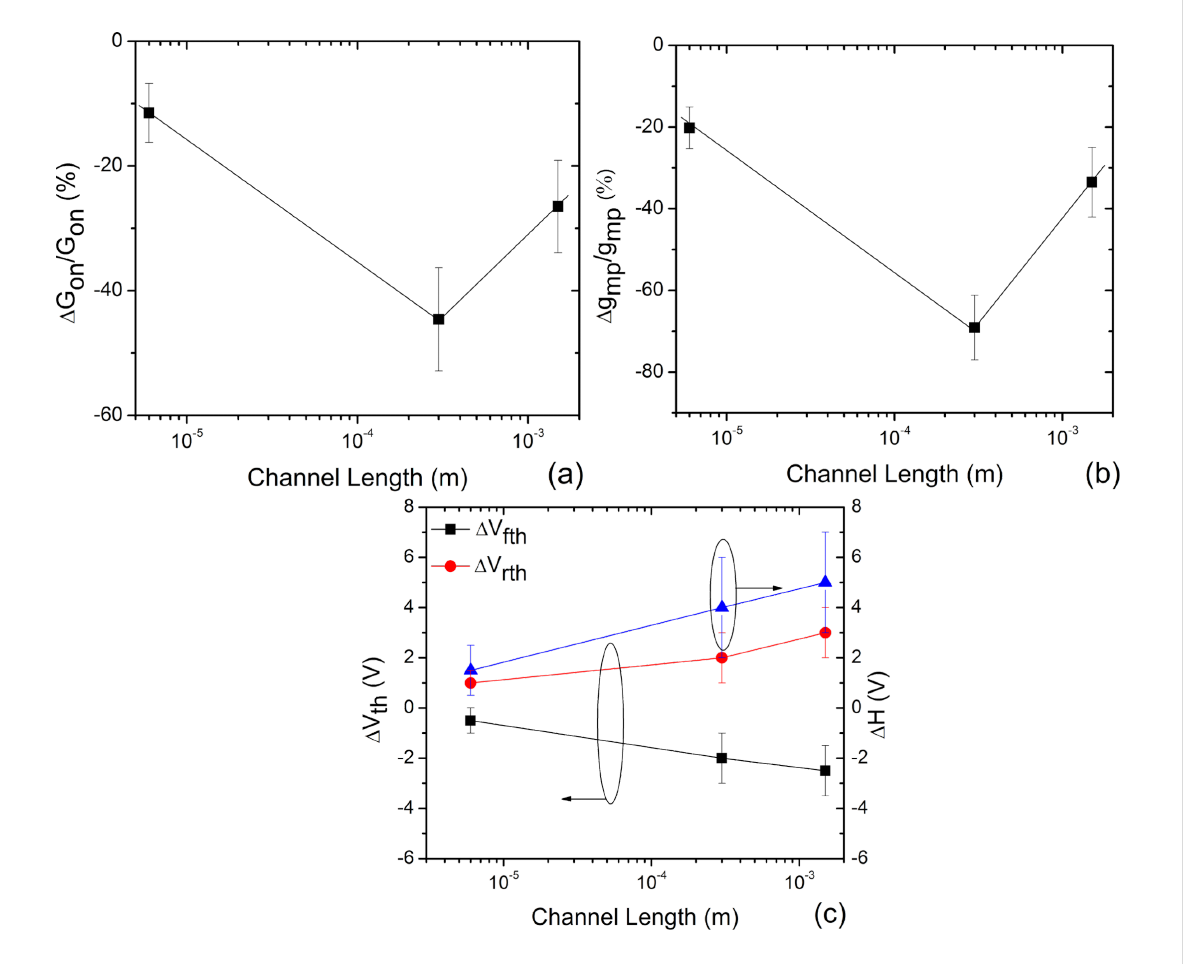
Figure 4: The relative (a) on state conductance ( Δ G on / G on ) and (b) peak transconductance ( Δ g mp / g mp ) after cDNA exposure, expressed in percent, for three different FET channel lengths ( L = 6 µm, 300 µm and 1500 µm) with both the channel and junction exposed. The negative sign on the y-axis indicates the decrease in magnitude of these two parameters after DNA hybridization. (c) The variation of the change in forward sweep threshold voltage ( Δ V fth ), reverse sweep threshold voltage ( Δ V rth ) and hysteresis gap ( Δ H ) induced by DNA hybridization with L . The negative and positive signs of the threshold voltage shifts indicate the negative and positive shift in the transfer curves. A positive Δ H indicates the rise in hysteresis. The changes in all electrical parameters induced by DNA hybridization are obtained with respect to the “before cDNA” I D –V G curves. The solid lines are a guide to the